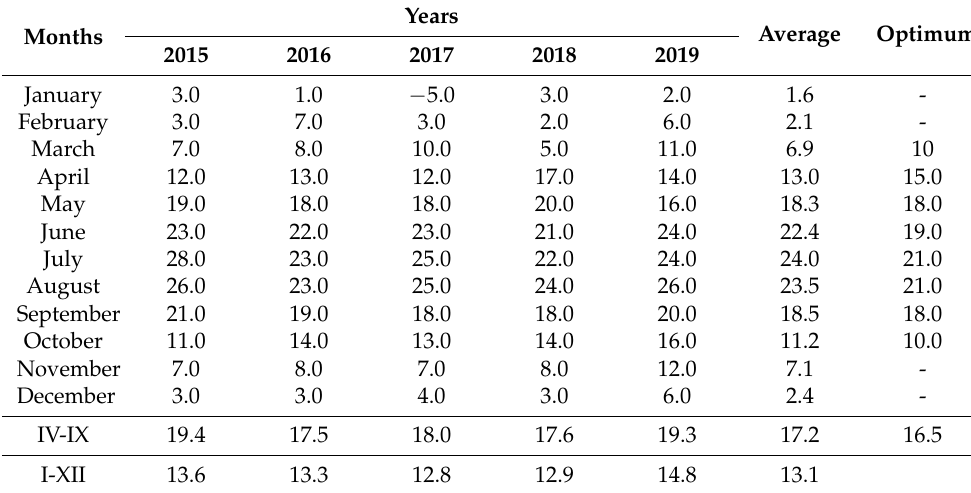
Table 2. Average air temperatures ( ◦ C) during 2015–2019.